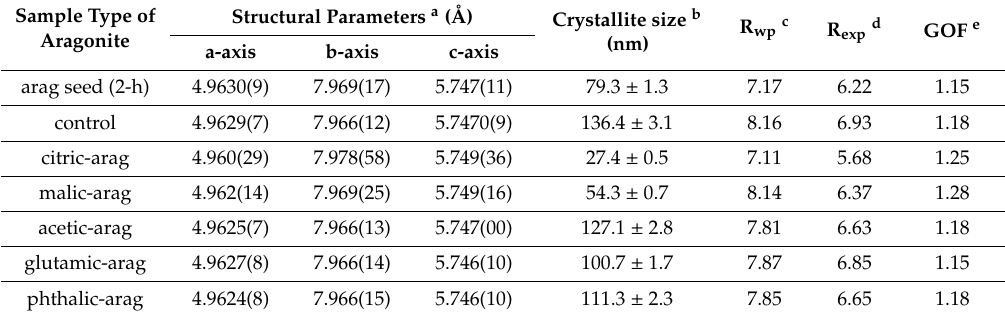
Table 2. Refined structural parameters and crystallite sizes of the used aragonite seed and the organic co-precipitated aragonite samples.